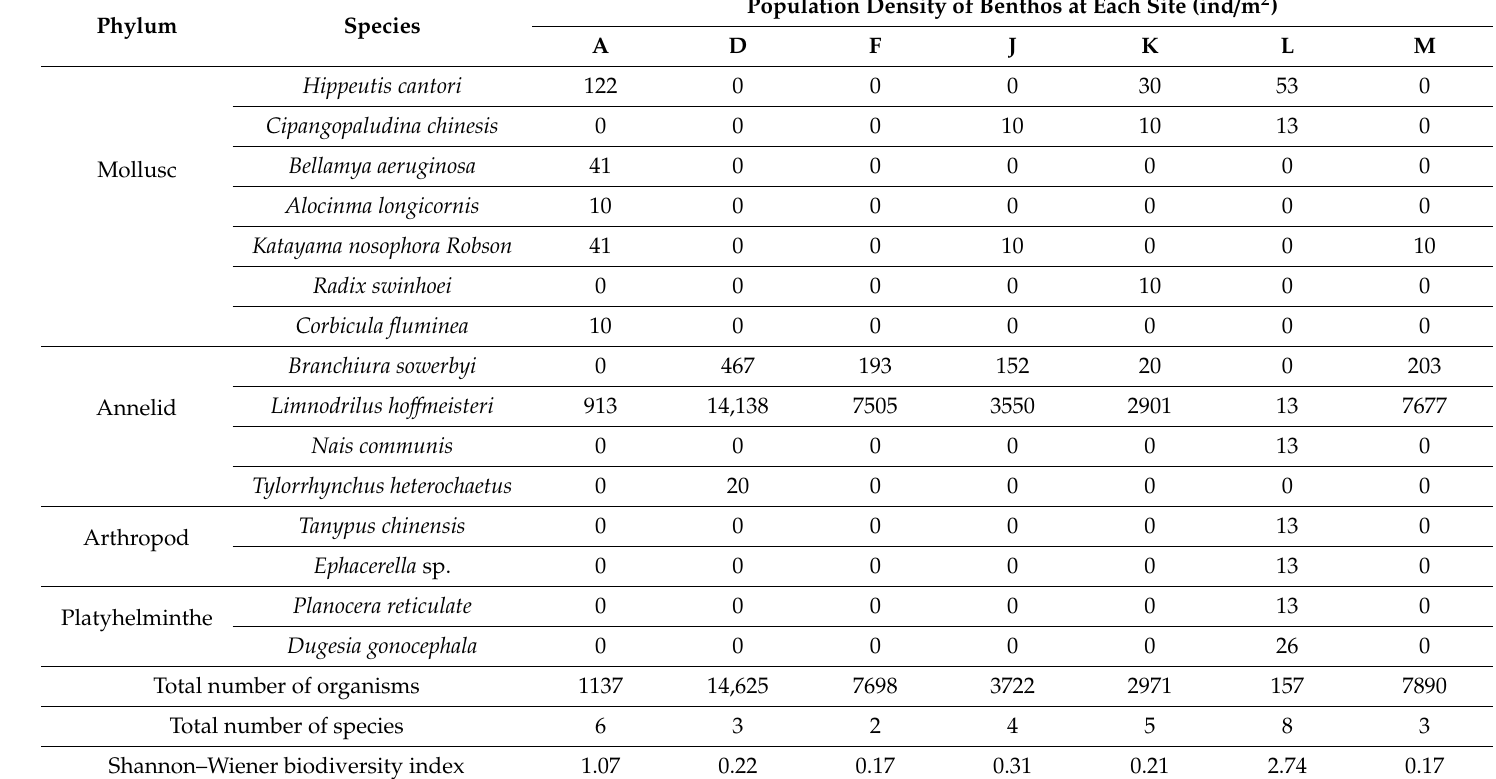
Table 4. Population density of benthic organisms in selected